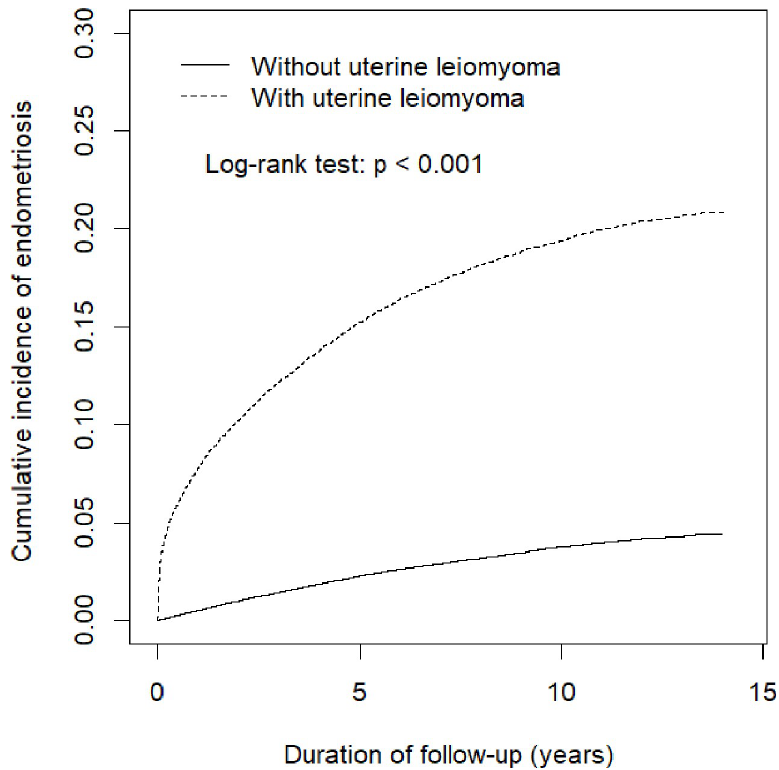
Fig 2. Kaplan-Meier analysis of endometriosis risk in patients with and without uterine leiomyoma. HR = hazard ratio; CI = confidence interval.